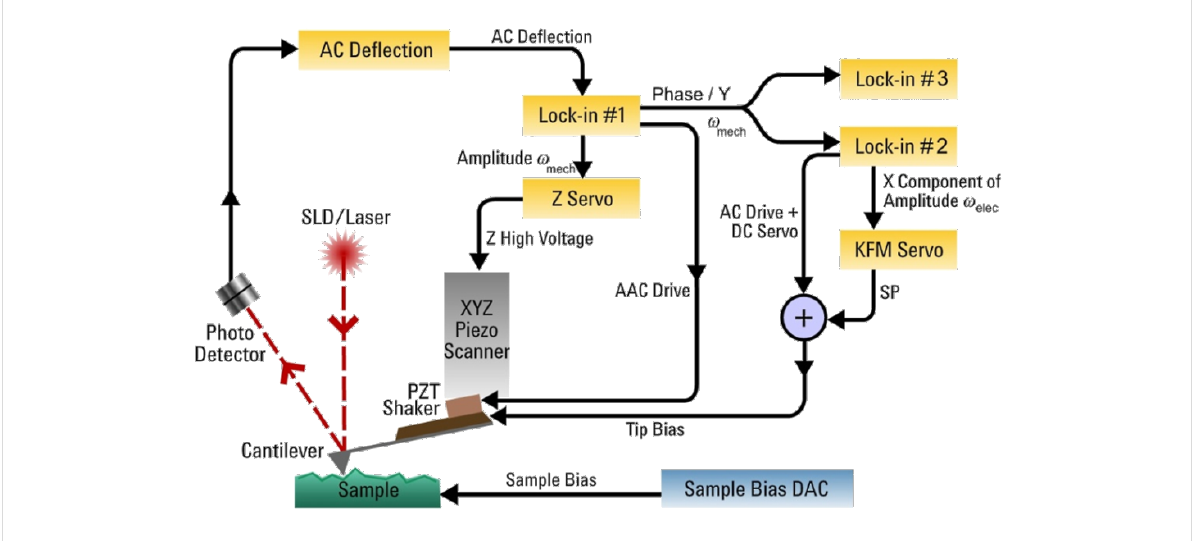
Figure 1: Sketch illustrating implementation of Kelvin force microscopy in the AM–FM mode. Two servo-loops, which are based on the lock-in ampli- fiers, are employed for the simultaneous detection of the mechanical and electrostatic tip–sample interactions at different frequencies: ω mech and ω elec